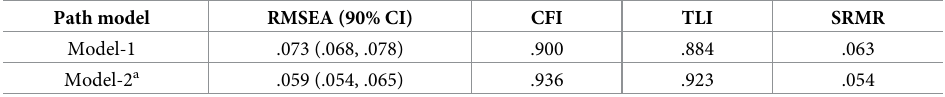
Table 1. Summary for PNSE-M model fit